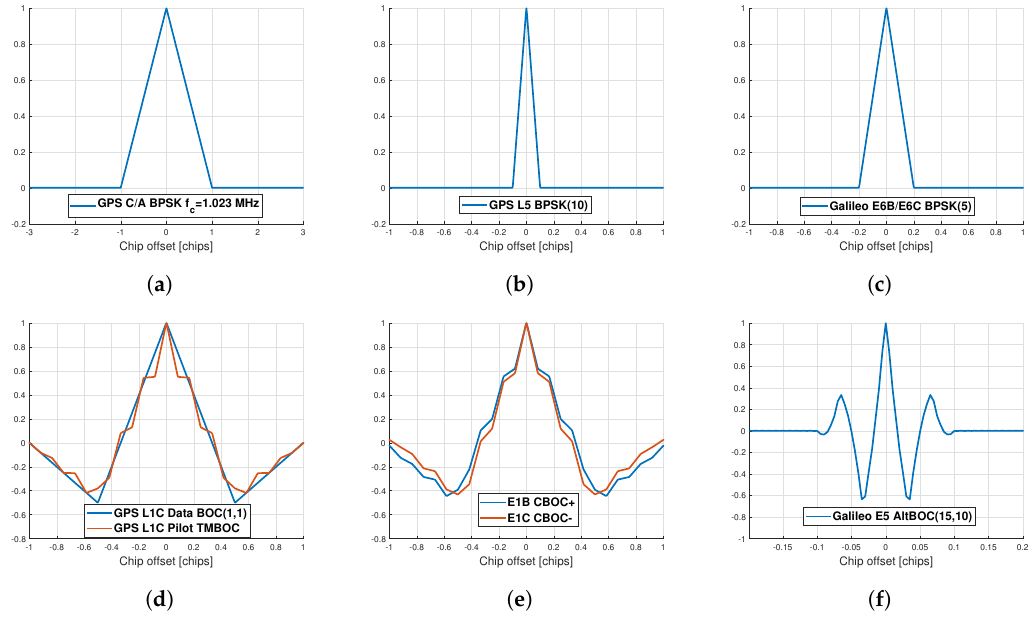
Figure 2. ACF of the GPS L1 C/A ( a ), GPS L5 ( b ), Galileo E6 ( c ), GPS L1C ( d ), Galileo E1 OS ( e ) and Galileo E5 ( f